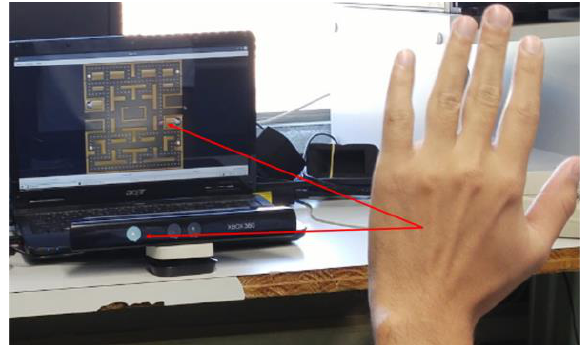
Fig. 1. GestureChair interface is running from gestural